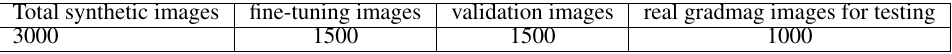
Table 1. The number of synthetic fine-tuning, synthetic validation and real testing images for the five networks.